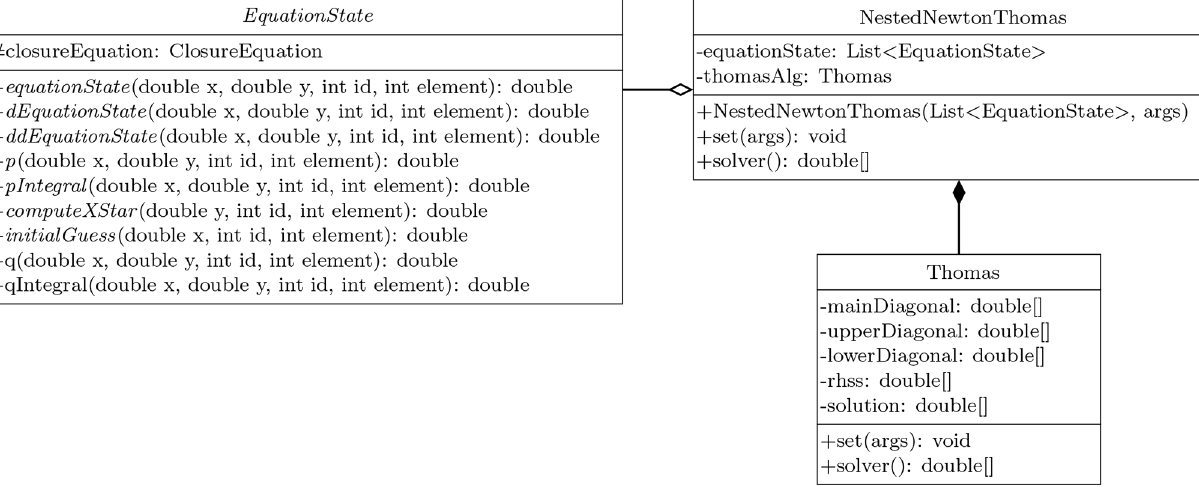
Figure 7. UML class diagram of the NestedNewtonThomas class. This class deals with the solution of the nonlinear system. The NestedNewtonThomas contains a reference to the Thomas object, whose task it is to solve a linear system, and to a list of EquationState